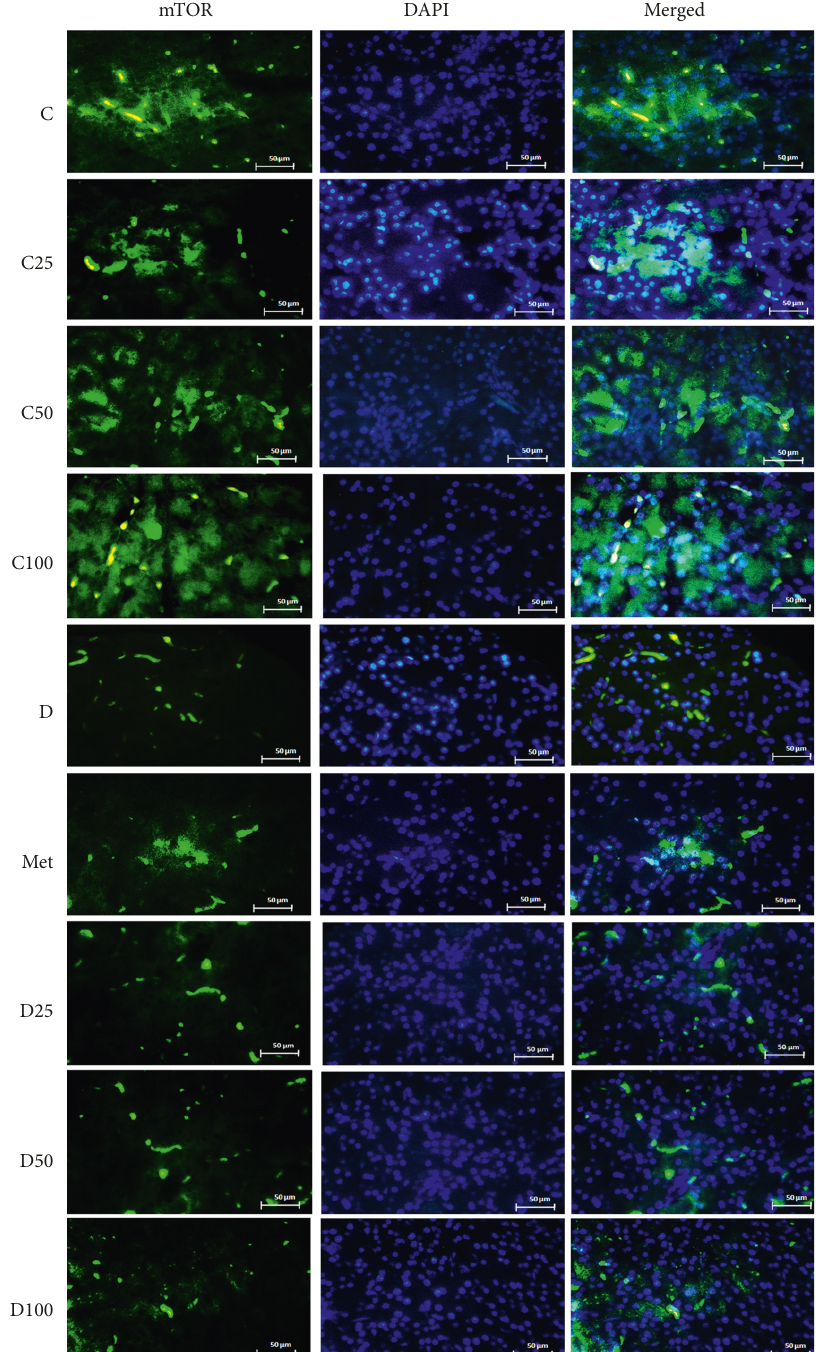
Figure 4: Fluorescence immunocytochemistry analysis of mTOR. C: control rats, D: the sham or diabetic rats, MET: diabetic rats +metformin (55mg/kg), C25: control rats +p-cymene (25mg/kg), C50: control rats+ p-cymene (50mg/kg), C100: control rats +p- cymene (100mg/kg), D25: diabetic rats +p-cymene (25mg/kg), D50: diabetic rats+ p-cymene (50 mg/kg), D100: diabetic rats +p-cymene (100mg/kg). Magnification 400x. Scale bar 50 μ